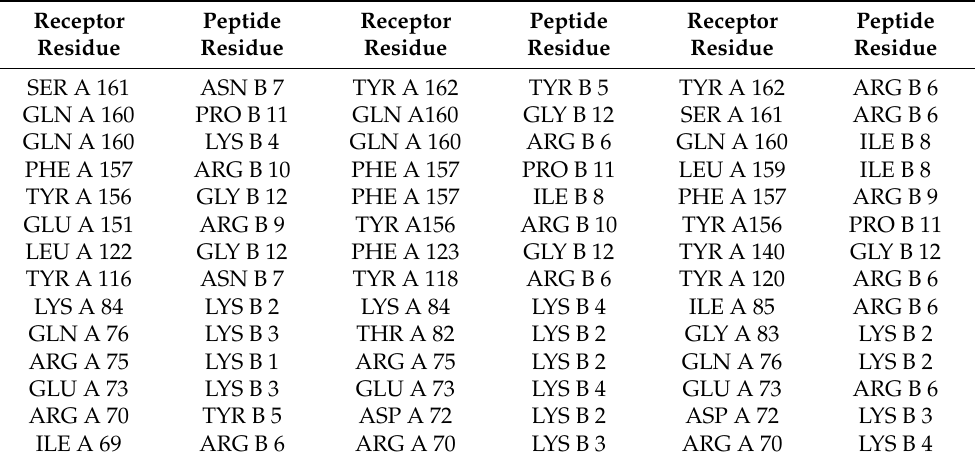
Table A2. Pairs of peptide/receptor residuals closer than 4.5 Å in the selected complex using the CABS-dock method [28]. Peptide sequence was KKKKYRNIRRPG [75] and receptor region was aa 334–523 of RBD S1 SARS-CoV-2.